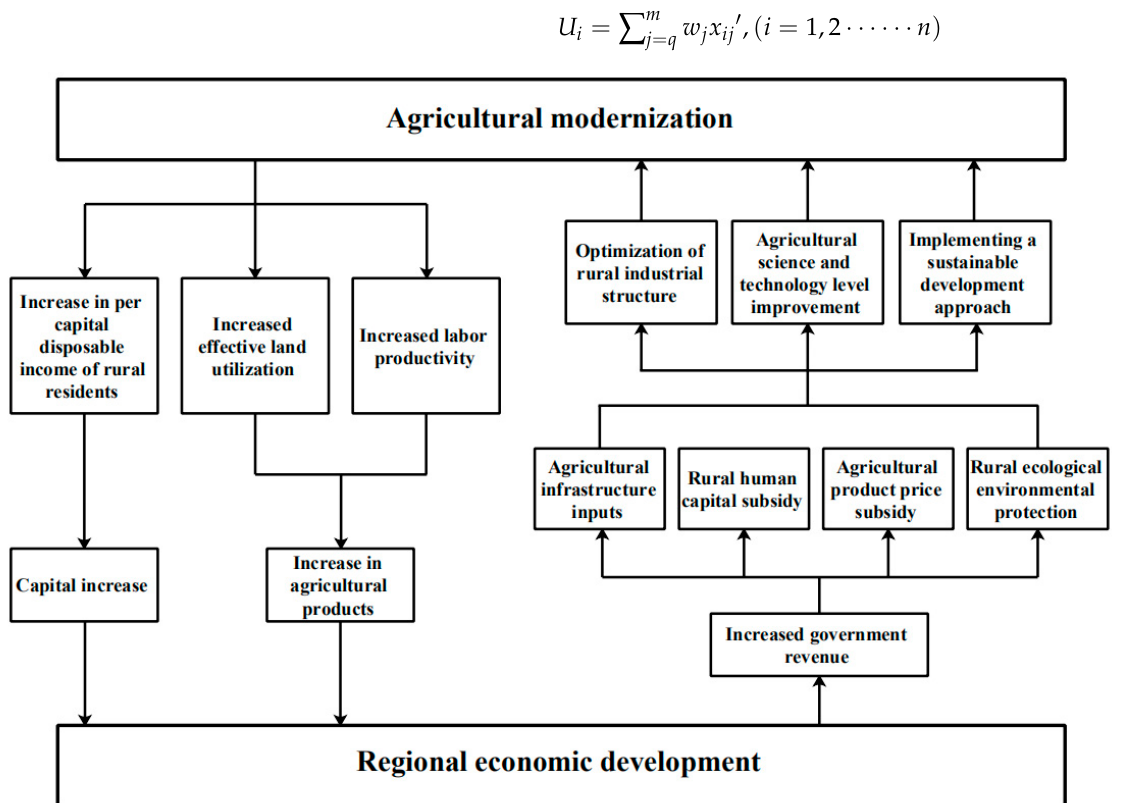
Figure 1. The coupling mechanism of agricultural modernization and regional economic develop- ment.